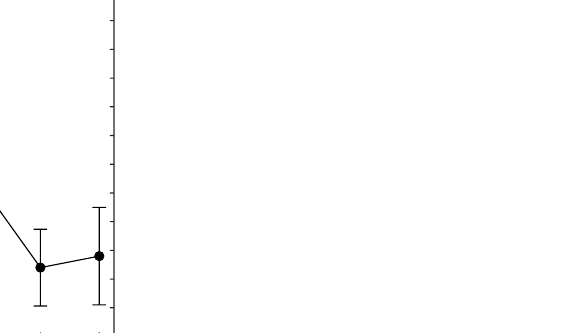
Figure 19. Strain – initial stress plot for area B obtained by the ESPI measurement.